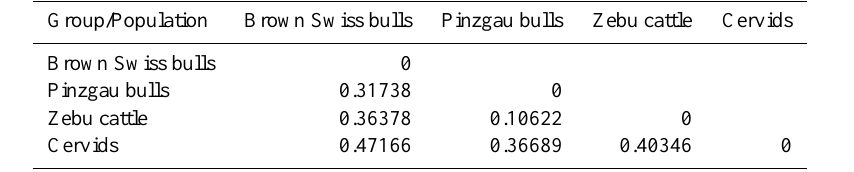
Table 4. The pairwise F ST values between analysed groups.